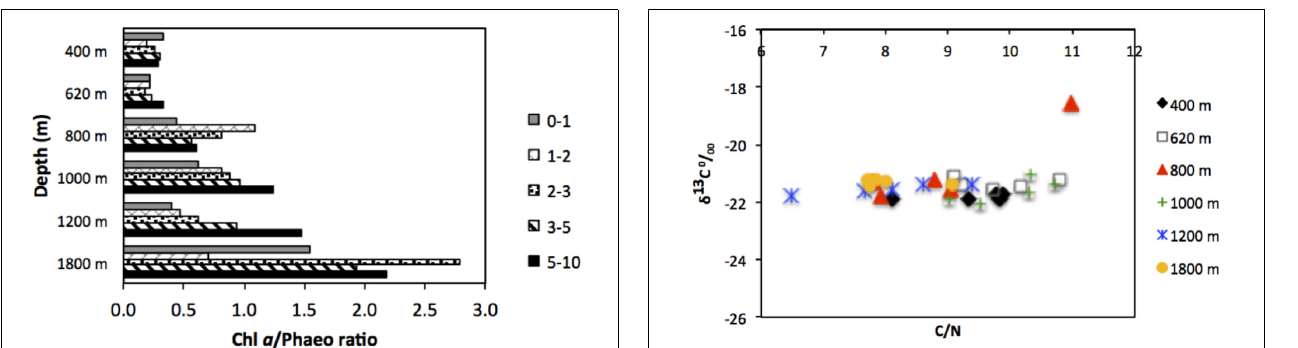
Sedimentary parameters are given for the top 0–1 cm layer. BT, bottom water temperature; DO, bottom-water dissolved oxygen; TOC, total organic carbon; TN, total nitrogen; C/N, molar carbon/nitrogen ratio; WC, water content; Chl a, chlorophyll a; Phaeo, phaeopigments; CPE, chloroplastic pigment equivalents. ∗ Surface Net Primary Production data (courtesy of M. Kahru, SIO).